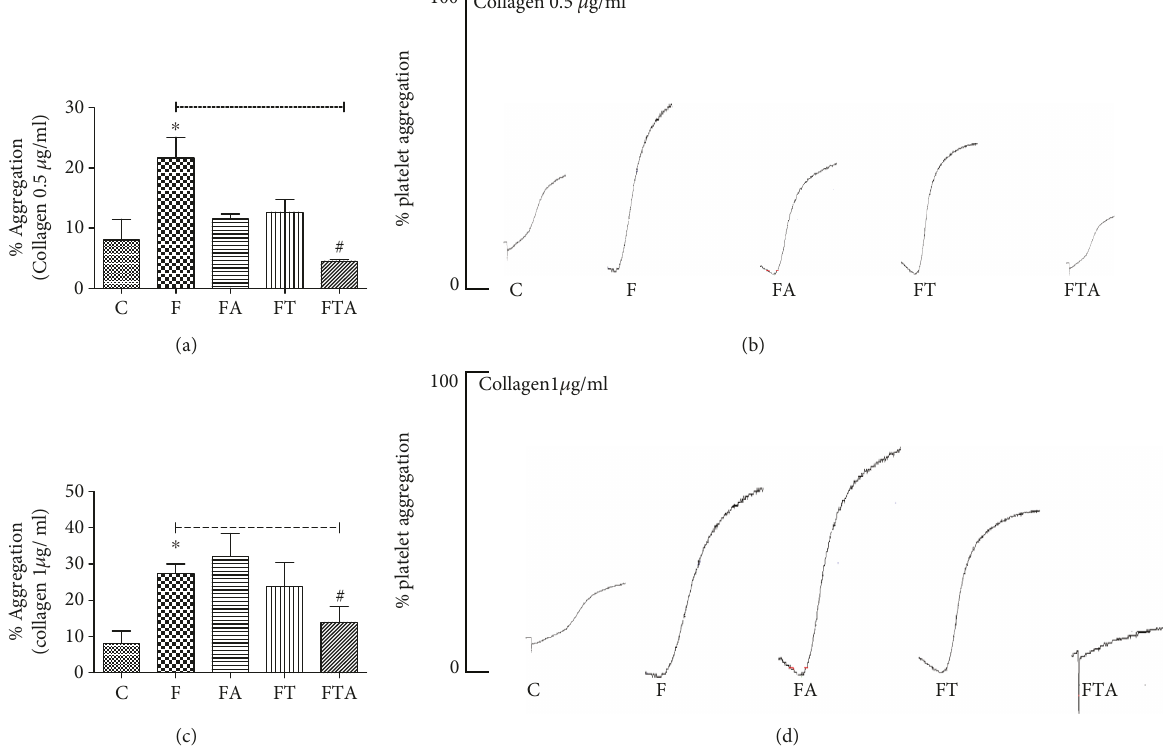
Figure 2: Platelet aggregation induced by collagen 0.5 μ g/ml (a, b) and collagen 1 μ g/ml (c, d) after 8 weeks of fructose overload. C group: control group; F group: fructose group; FA group: fructose+arginine group; FT group: fructose+training group; FTA group: fructose +training +arginine group. Data are presented as means ± SEM . Statistical analysis (one-way ANOVA and post hoc Bonferroni multiple-comparison test): ∗ P < 0 05 v. the C group and # P < 0 05 v. the F